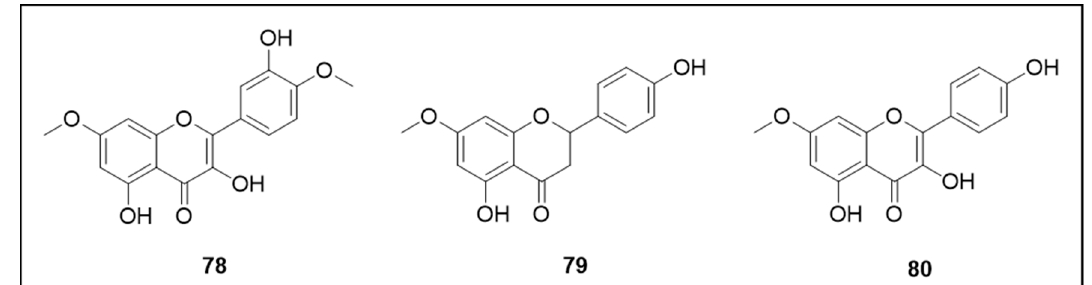
Figure 11. Flavonoids active against Ae. aegypti .